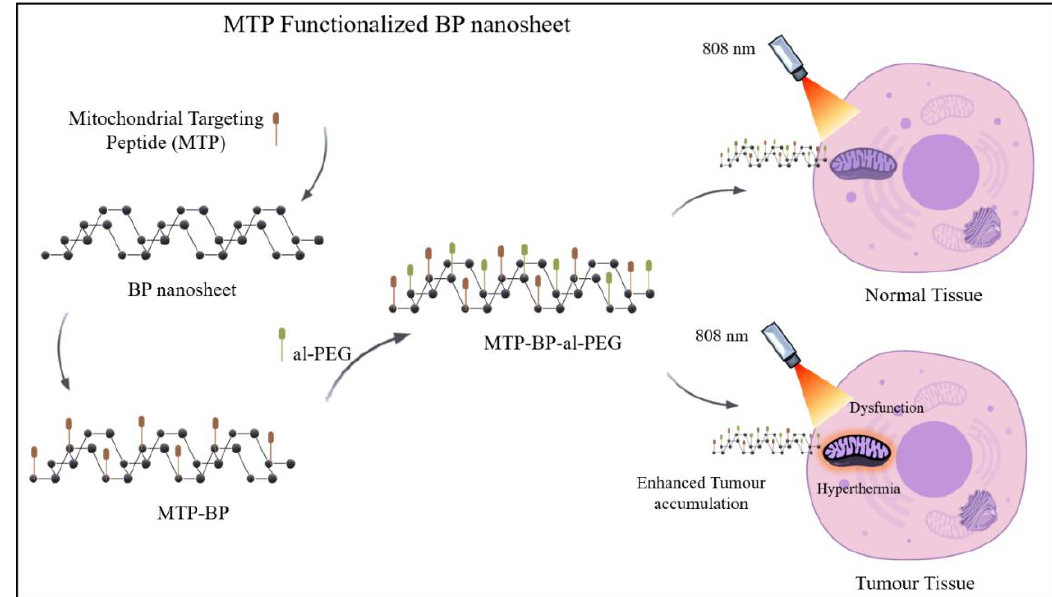
Figure 2. Mitochondrial Targeting Peptide (MTP)-functionalized BP nanosheets for enhanced tumor accumulation and mitochondria targeting.